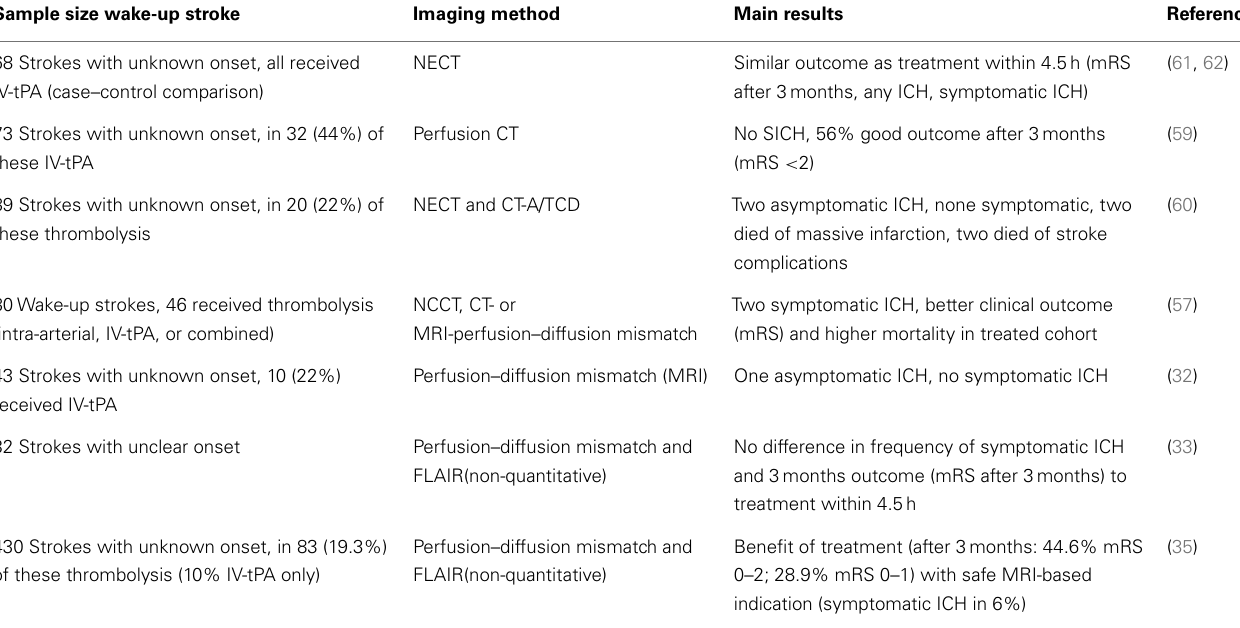
Table 2 |Trials with thrombolysis with indication set by imaging in wake-up